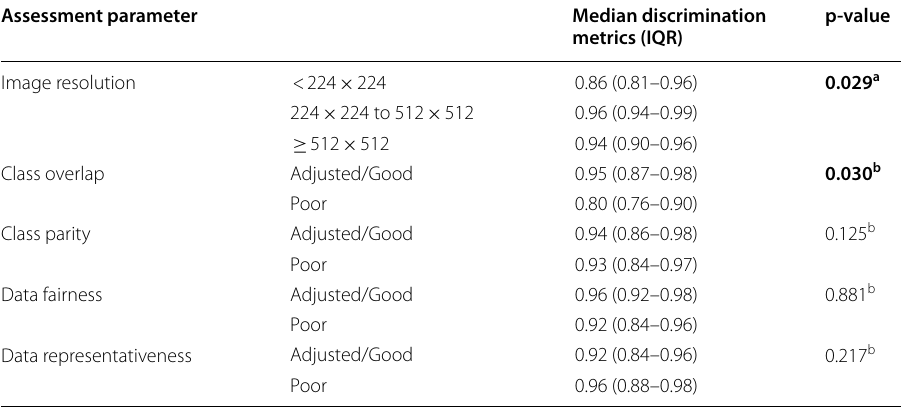
a Kruskal-Wallis H test b Mann Whitney U test used for analysis P-value in bold is statistically